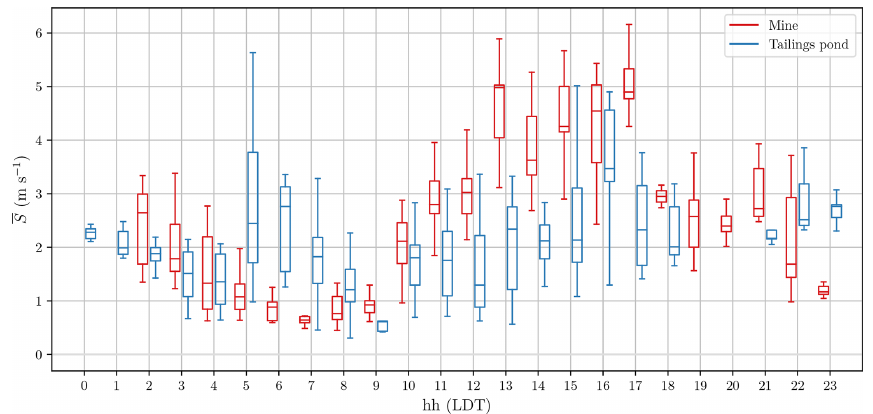
Figure 12. Diurnal variation of mean wind speed; at each hour, observations are plotted using statistical percentiles (5th, 25th, 50th, 75th, and 95th); times are in